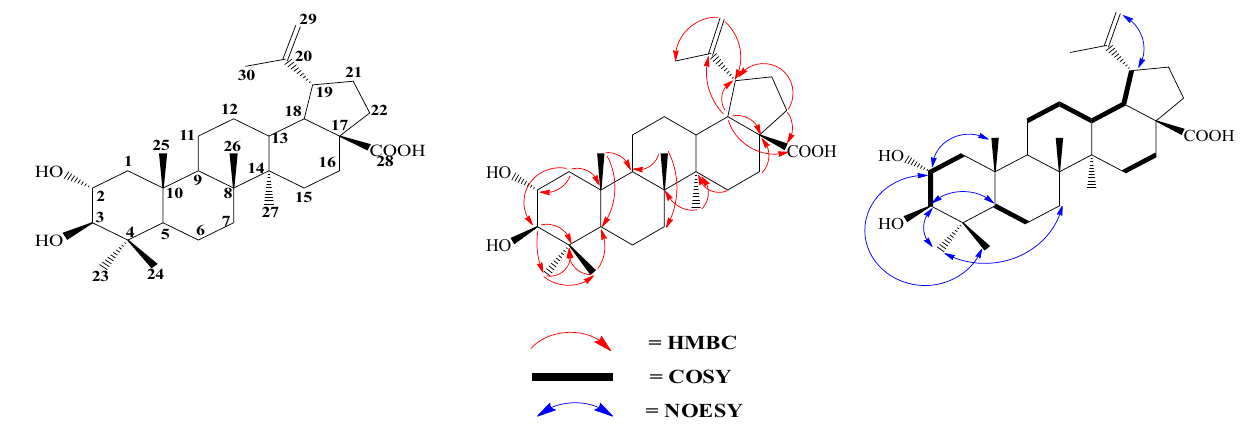
Figure 1: DQF - COSY, NOESY, and HMBC correlations of alphitolic acid from S.